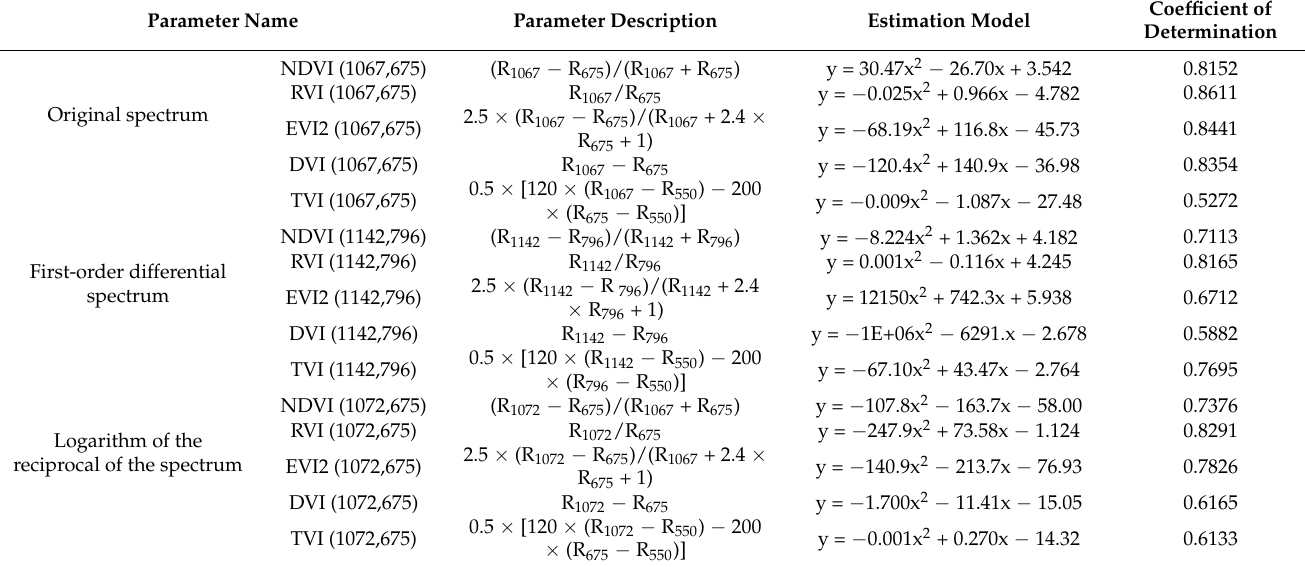
Table 3. Details of the models used to estimate the leaf area index of cotton during the whole growth